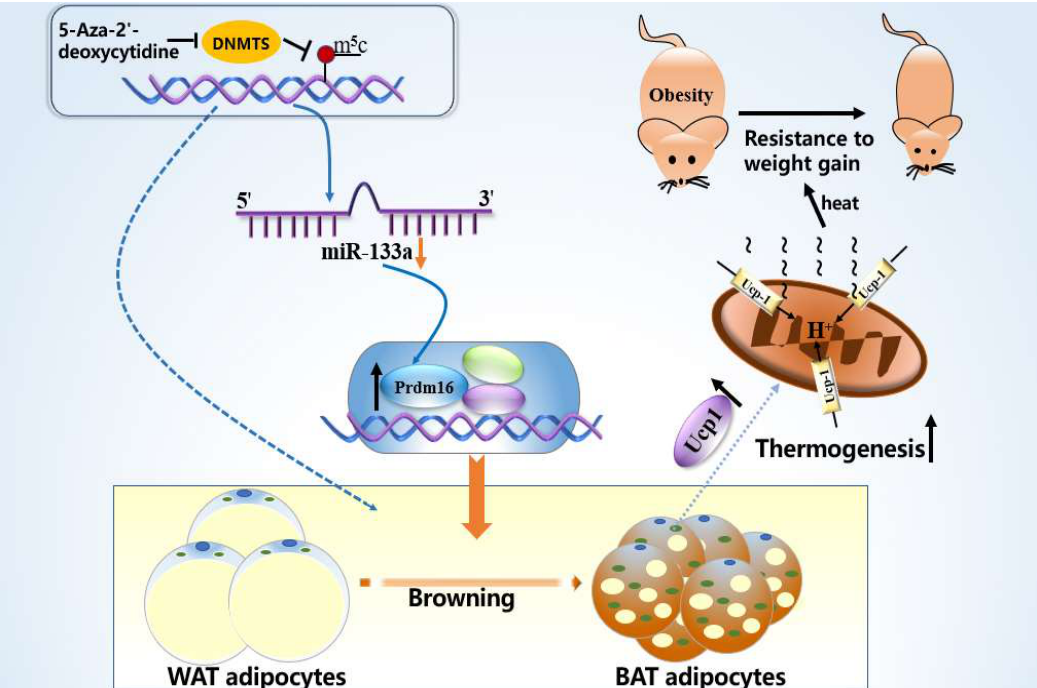
Figure 7. Graphic of 5-Aza-dC-mediated browning of white adipocytes. 5-Aza-dC suppresses the expression of miR-133a, which is a direct inhibitor of Prdm16. Thus, the 5-Aza-dC-mediated suppression of miR-133a upregulates the expression of Prdm16 and promotes the browning of white fat, increasing Ucp-1 expression and thermogenic activity, which contributes to resistance to weight gain. miR-133a, microRNA-133a; Prdm16, PR domain containing 16; Ucp-1, uncoupling protein 1.